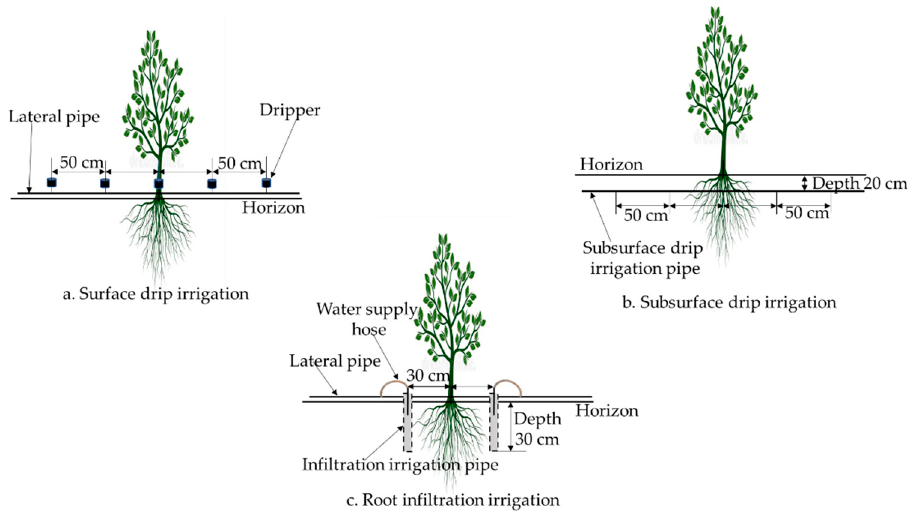
Figure 3. Three methods of irrigation. ( a ) Surface drip irrigation, a row consisting of two pipes was laid on both sides of the tree row, the drip head flow was 2 L/h, the distance between the drip heads was 50 cm, and the pipes were 40 cm away from the trees; ( b ) Subsurface drip irrigation, a row of two pipes was buried 20 cm below the surface, the drip head flow was 2 L/h, the distance between the drip heads was 50 cm, and the pipes were 40 cm away from the trees; ( c ) root zone infiltration irrigation, a pipe to supply water was laid at the bottom of the tree in each row. Holes to supply the water pipe were drilled every 50 cm, and polyethylene (PE) microtubes connected the holes to the seepage pipe. Two seepage pipes per plant were buried on either side, 30 cm from the rows of trees. Two rows of symmetrical water seepage holes with a diameter of 2 mm that were spaced 1 cm apart were drilled into the wall of the tube, which was buried 30 cm below the surface. A nozzle with a flow rate of 2 L/h connected by PE microtubes was placed inside the tube.